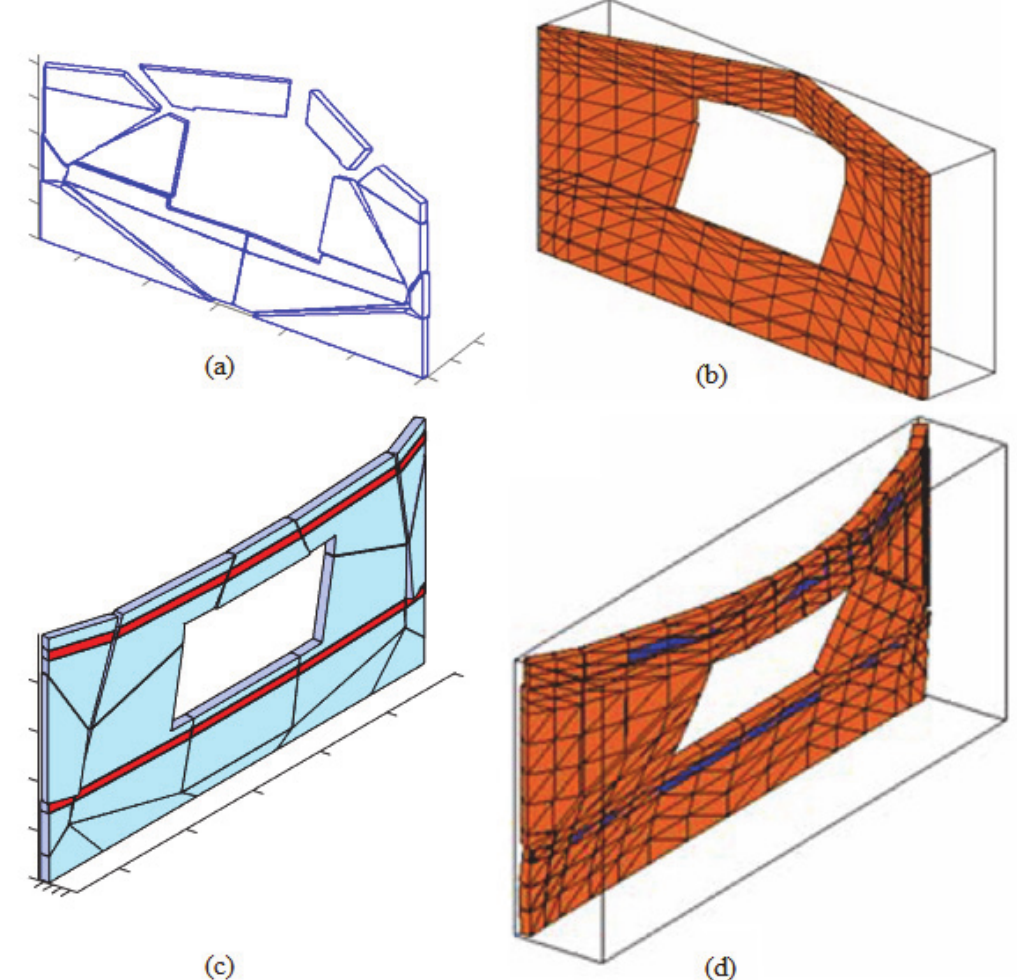
Figure 10: SB02 masonry panel with rectangular opening tested in [51]. (a-c) Unreinforced and reinforced case, respectively: collapse mechanism with the GA-NURBS approach; (b-d) Unreinforced and reinforced case, respectively: collapse mechanism with the homogenized FE limit analysis proposed in